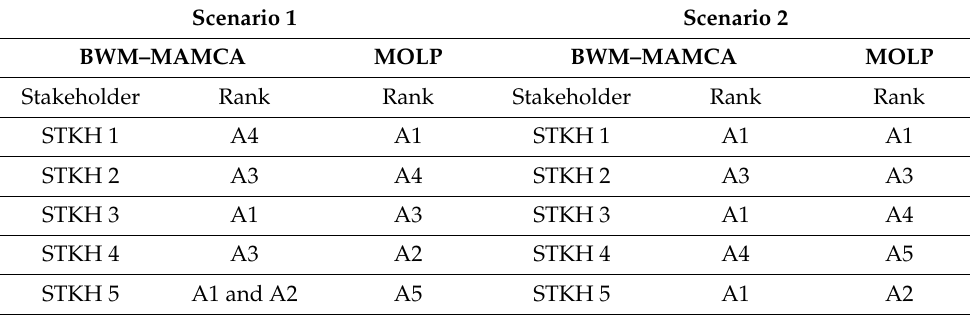
Table 8. Comparison of Scenario 1 and Scenario 2